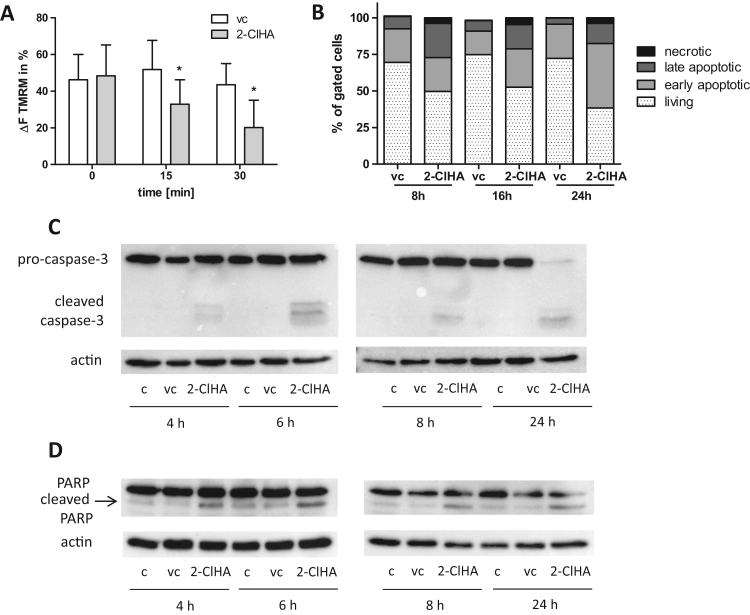
2-ClHA dissipates ΔΨm and induces apoptosis in hCMEC/D3 cells. Serum-starved cells were incubated in the presence of DMSO (0.1%, vehicle control, vc) and 2-ClHA (10 μM) for the indicated time points. (A) The bar graphs display quantification of TMRM fluorescence in vehicle (DMSO, 0.1%) and 2-ClHA-treated cells. Single cell measurements were background corrected and bleach corrected. The delta fluorescence (ΔF) intensity between basal and depleted membrane potential after FCCP treatment was measured. Results shown represent mean + SD. (B) Cells were trypsinized at the indicated time points, stained with Annexin V-FITC and propidium iodide (PI) and analyzed by flow cytometry. The bar graph summarizes the proportion of necrotic (A−/PI+), late apoptotic (A+/PI+), early apoptotic (A+/PI−), and living (A−/PI−) cells from two independent experiments performed in triplicates. Representative scattergrams are shown in Fig. S3. (C,D) At the indicated time points cells were lysed and (C) pro-caspase-3 and (D) PARP cleavage (arrow = 89 kDa product) was analyzed by Western blotting experiments. β-Actin was used as loading control. One representative blot out of three is shown. Densitometric and statistical evaluation is shown in Fig. S4.